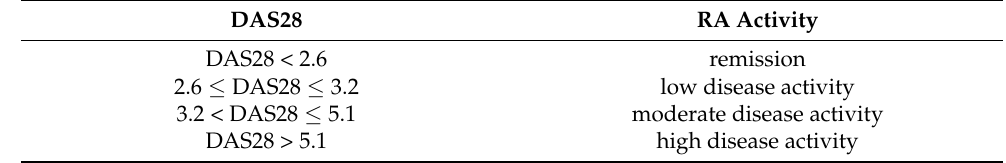
Table 1. Discrimination of works based on deep learning model data input [36,37].